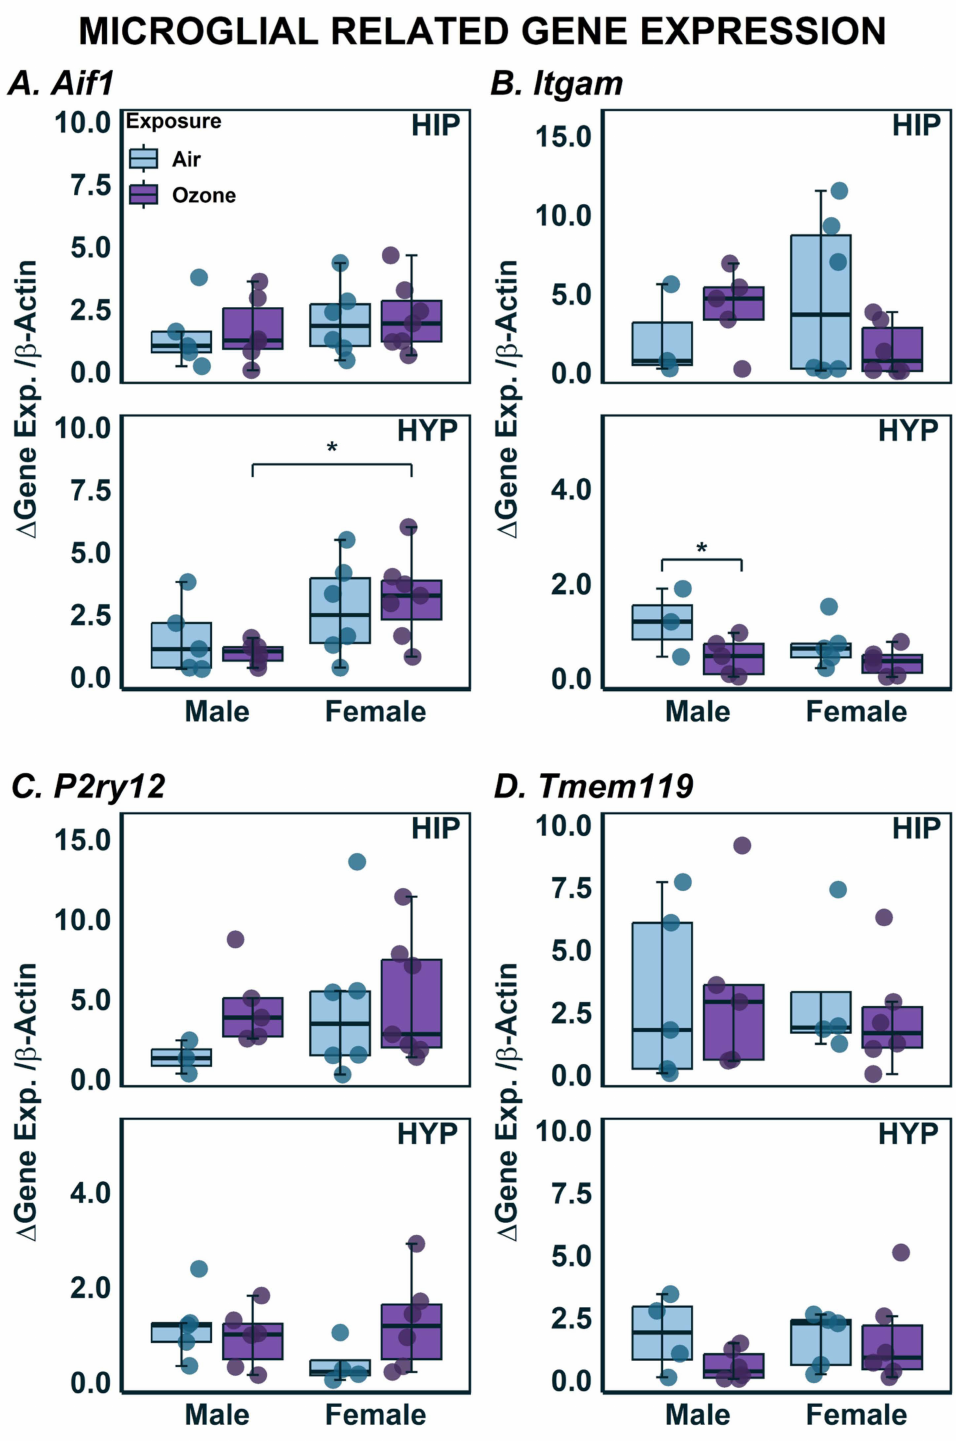
Figure 5. Microglial Associated Gene expression in the hippocampus (HIP) and hypothalamus (HYP) following ozone exposure in male and female rats. ( A ) Aif1 ; ( B ) Itgam ; ( C ) P2ry12 ; ( D ) Tmem119 expression was assessed using qPCR in HIP and HYP. Data are expressed by boxplots where n = 4–6 after removal of outliers using Tukey’s Interquartile Range (IQR) outlier test. * Represents post-hoc statistical differences where p <